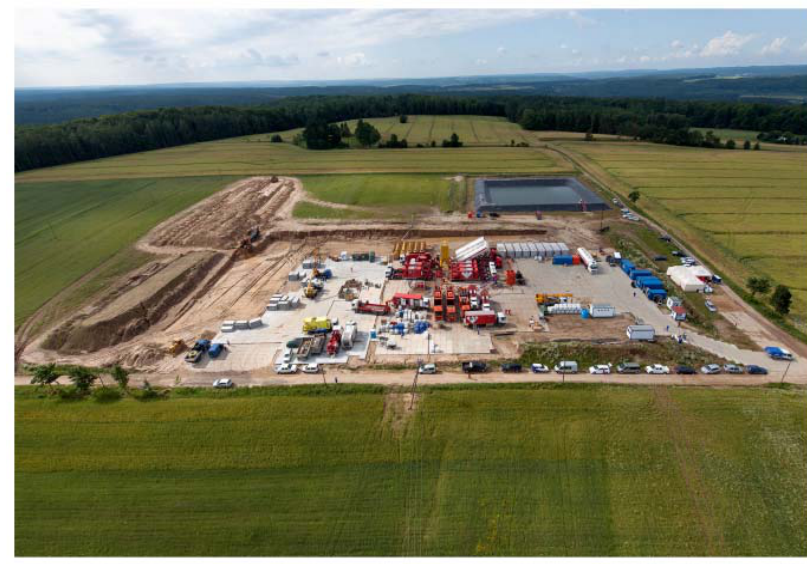
Figure 3. Well site prepared for